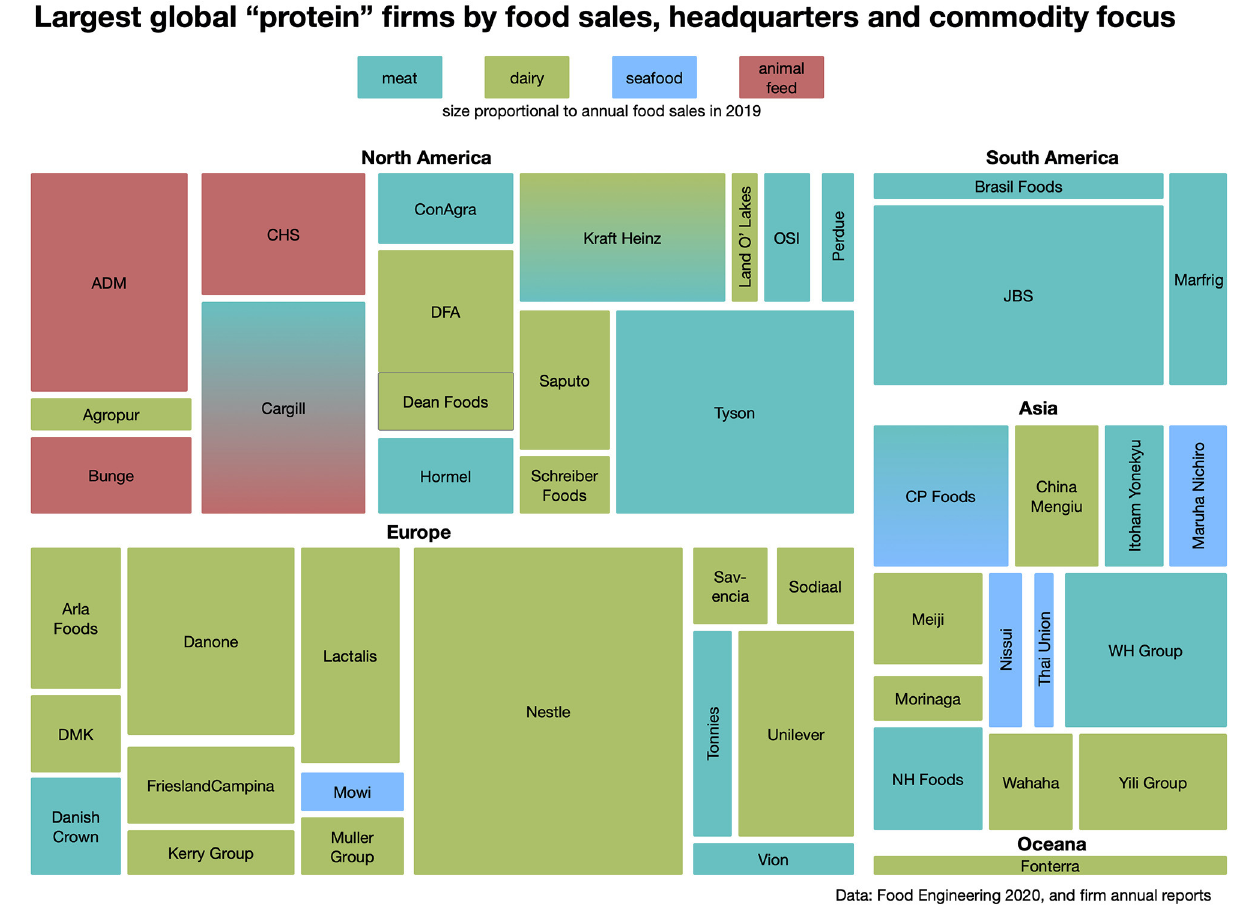
FIGURE 2 | Treemap of largest global “protein” firms by food sales, headquarters and commodity focus, with size proportional to annual food sales in